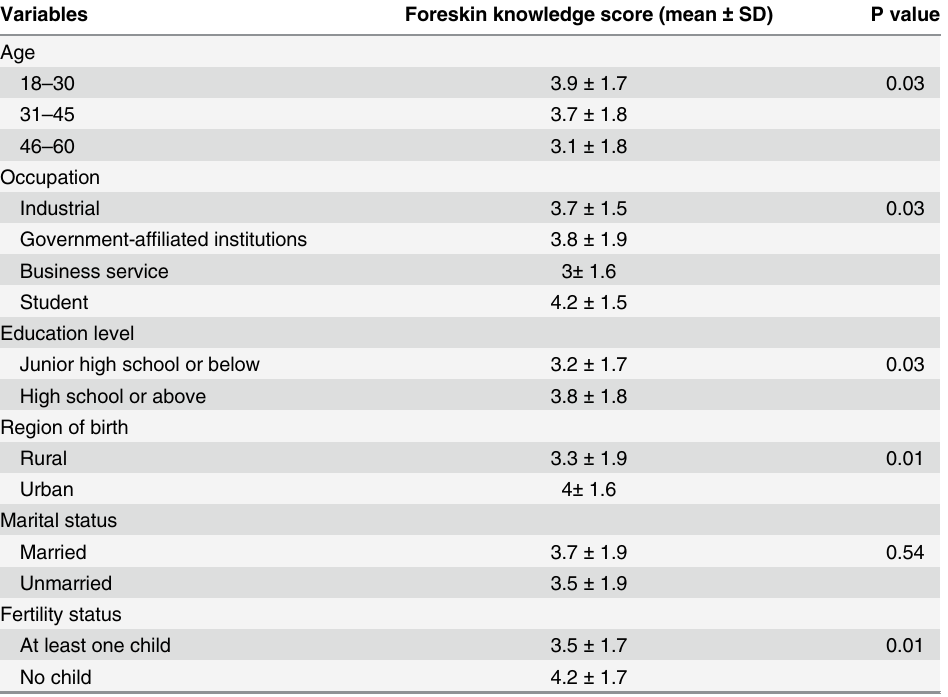
Table 4. Foreskin knowledge score by age, occupation, education level, birthplace, marital status and fertility